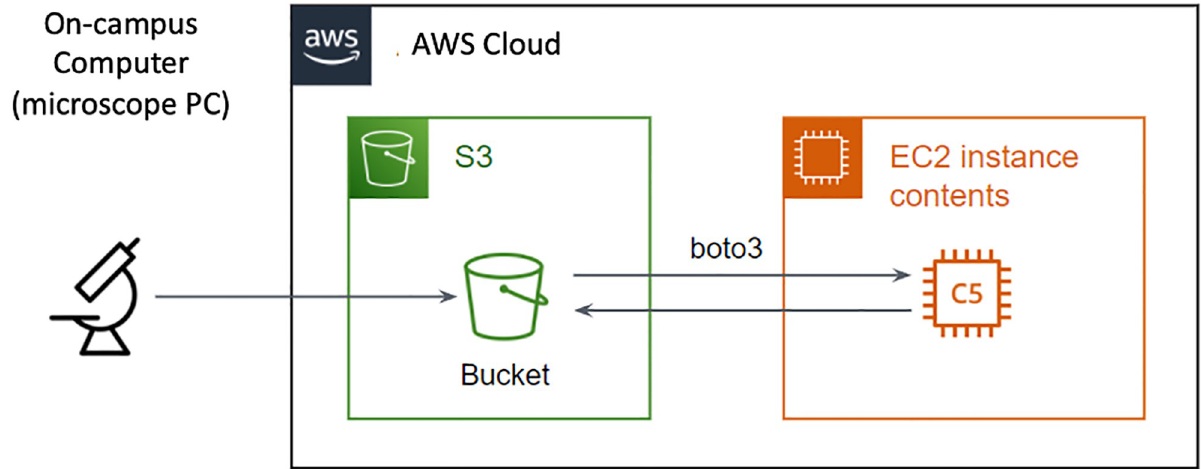
Fig 1. Outline of the pipeline used to work with AWS. Data from the microscope is moved to S3 data storage using university-provided networks. Data transfer rate can range between 10-100Mb/s. Within AWS cloud infrastructure, data is moved at > 10GB/s from storage to EC2 virtual machines to be processed through a Python or Julia Jupyter